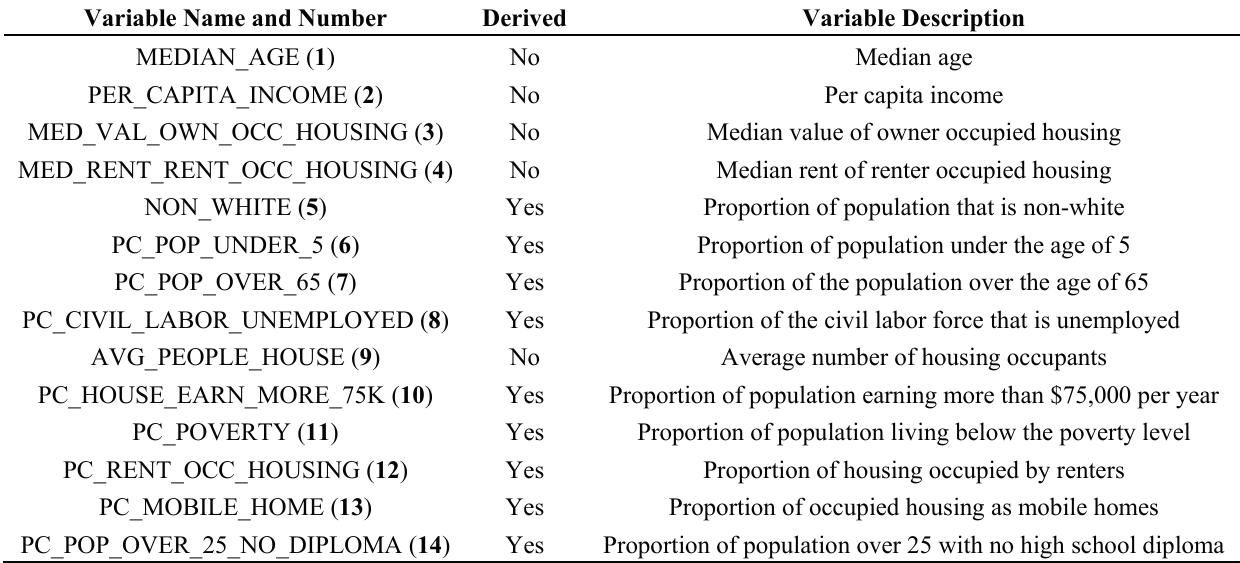
Table 1. Subset of the United States Census Bureau’s American Community Survey (ACS) variables used in the study with descriptions and whether the variable was derived from a larger group of variables from the ACS